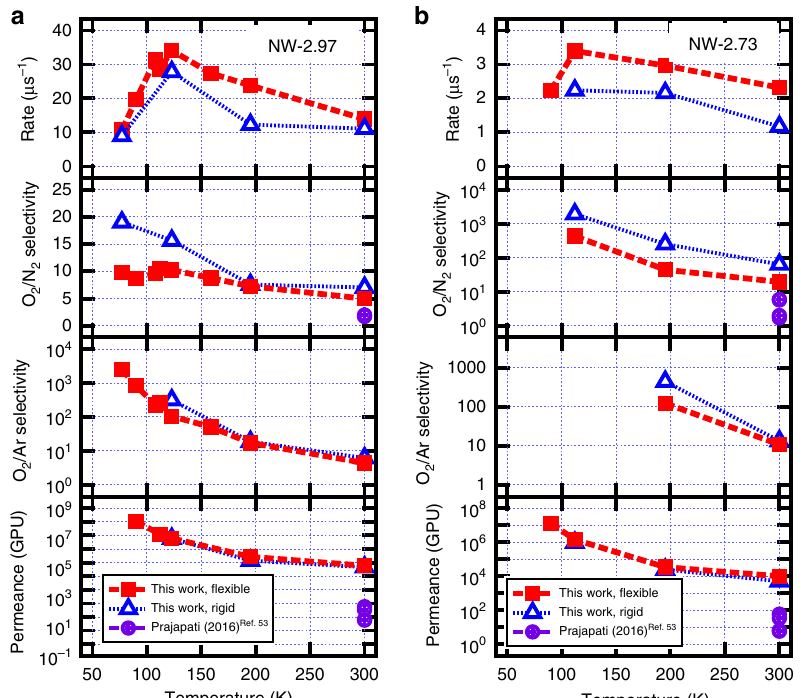
Fig. 6 Nanowindows NW-2.97 and NW-2.73 effectively separate air. Temperature dependence for the various parameters in a NW-2.97 and b NW-2.73. Optimum rates occur at a temperature with both high kinetic energy and high adsorption amounts. For calculation of GPU (10 − 6 cm 3 (STP) cm − 2 s − 1 cm Hg − 1 ), the ideal gas pressure was estimated from the density of the gas far from the surface where it behaves as